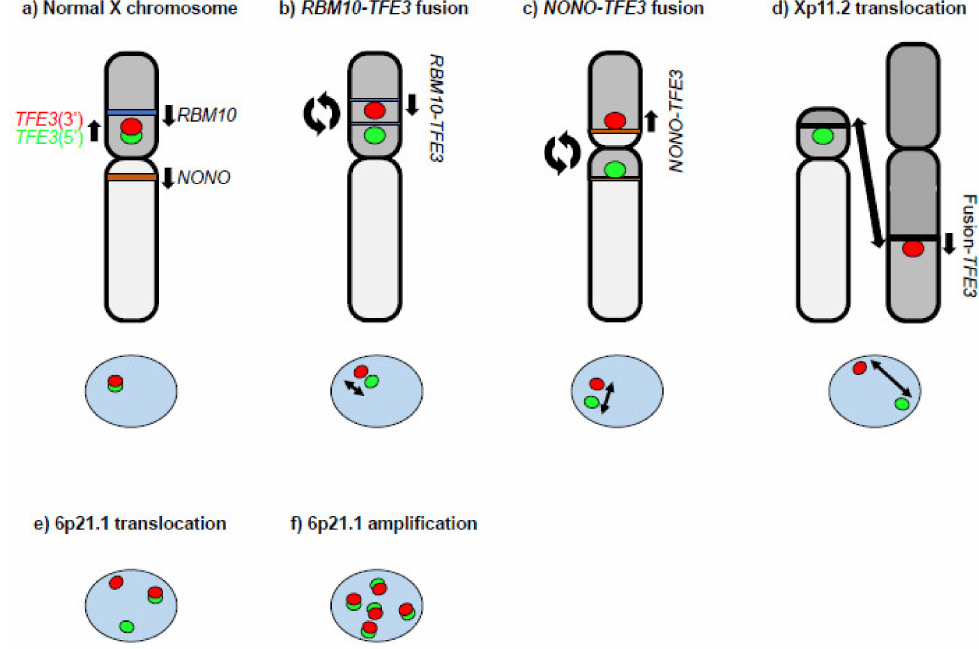
Figure 1. A diagram of TFE3 gene break-apart FISH. ( a ) The TFE3 gene is located at chromosome Xp11.2. The 5 (cid:48) FISH probe for TFE3 is green. The 3 (cid:48) FISH probe for TFE3 is red. A fusion